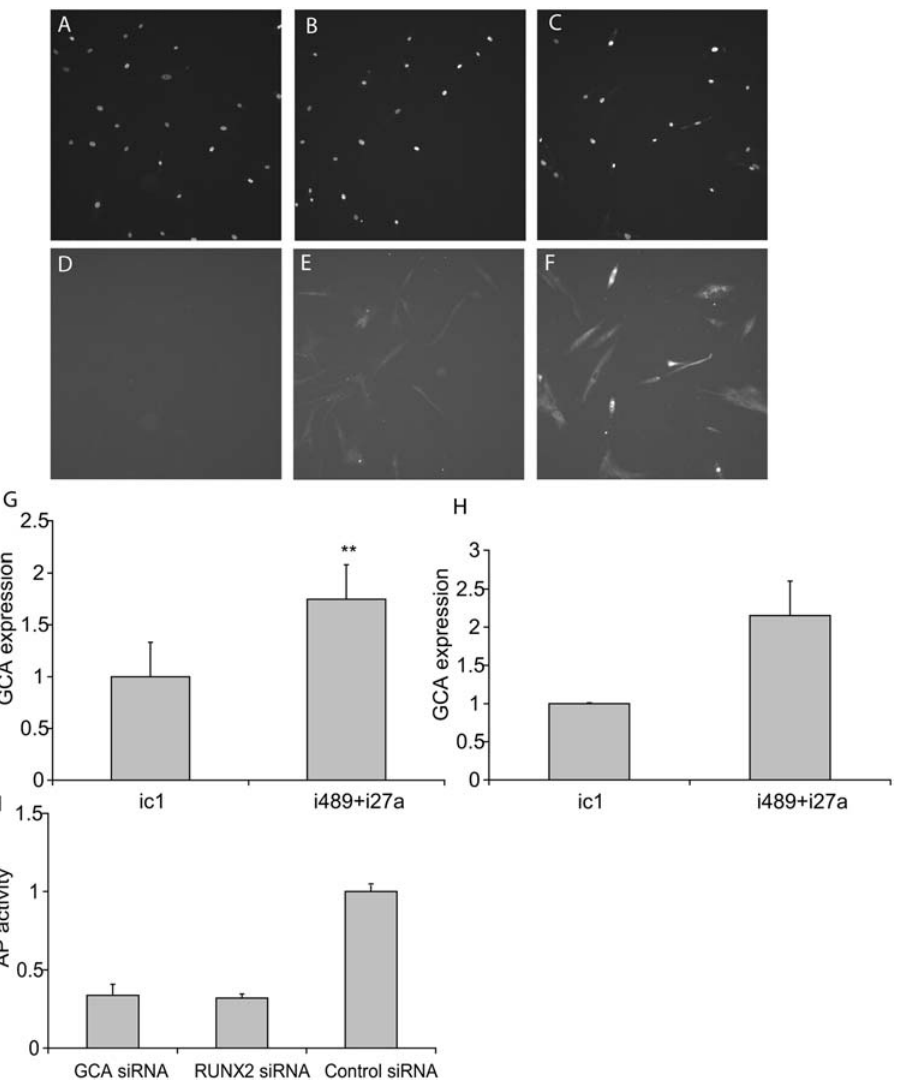
Figure 4. Negative effect of miRNAs, miR-489 and -27a, on osteogenesis in hMSC is, at least in part, mediated by repression of GCA gene expression. (A–G) Transfection with inhibitors of miR-489 and -27a results in up-regulation of GCA protein expression. (A–F). hMSC were transfected with control molecule, ic1 (25 nM) or with combination of inhibitors, i489 + i27a (12.5 nM each). GCA protein expression was determined by immunofluorescence as described in Materials and Methods. Cells were stained with Hoechst 33342 (A–C) and GCA specific primary antibody, followed by a secondary antibody (E,F). Control wells were treated with secondary antibody only and demonstrate no specific staining (D). (G) Quantitation of GCA immunohystochemistry. Data shown represents three independent transfections, four fields each. (mean + / 2 SD). ** - Student’s ttest p value between treated cells and corresponding control group, p , 0.05. (H) RT-PCR-based study of gene expression demonstrated that the expression of GCA mRNA is regulated by miR-489 and -27a. hMSC were transfected with Inhibitor Control molecule 1 (IC1, 25 nM) or with a combination of inhibitors for miR-27 and -489 (i27a + i489, 12.5 nM each). Transfected cells were incubated for 2 days in propagation media and then harvested for totat RNA. (I) siRNA-mediated knockdown of GCA (grancalcin) resulted in a significant decrease of AP activity in hMSC under differentiation conditions. hMSC were transfected with Control siRNA, RUNX2 and GCA siRNA (each at 50 nM). Cells were switched to osteogenic media 24 hr after transfection and harvested 6 days after the switch. Data shown represents two independent transfection experiments performed in duplicate (H) or triplicate (I) (mean + / 2 SD). **: Student’s ttest p value between treated cells and corresponding control group, p , 0.05.